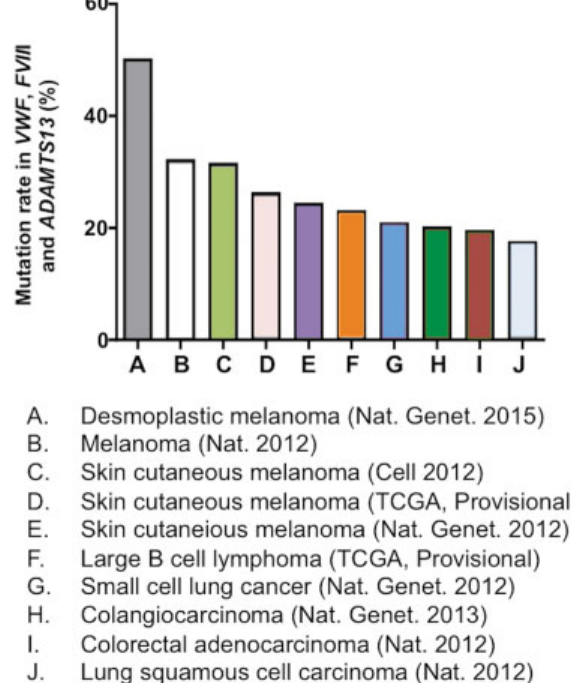
Fig. 1 Top-10 cancer studies show the highest mutation rates in genes encoding FVIII , VWF , and ADAMTS13 . The rates of FVIII , VWF , and ADAMTS13 mutations were obtained by searching database among 126 cancer studies using cBioPortal. Each bar represents the per- centage of mutation found in all three genes (e.g., FVIII , VWF , and ADAMTS13 ) in each individual